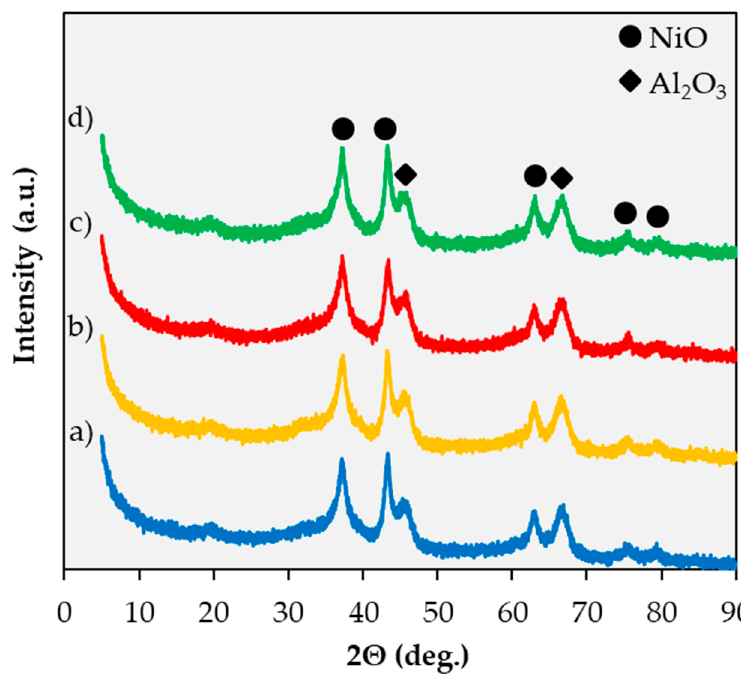
Figure 1. X-ray diffraction patterns for 20% Ni/Al 2 O 3 ( a ), 20% Ni-0.1% Pt/Al 2 O 3 ( b ), 20% Ni-0.25% Pt/Al 2 O 3 ( c ), and 20% Ni-0.5% Pt/Al 2 O 3 ( d ).